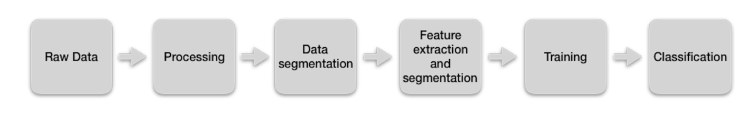
Figure 1. Activity recognition